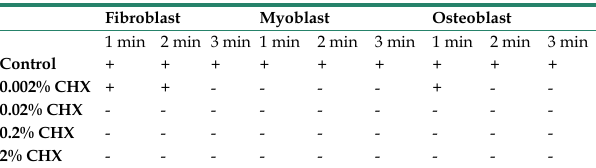
Table 2: Scratch test defect closure in fibroblasts, myoblasts, and osteoblasts 24 hours following CHX exposure for 1, 2, or 3 minute durations. “+” indicates closure. “-“ indicates no